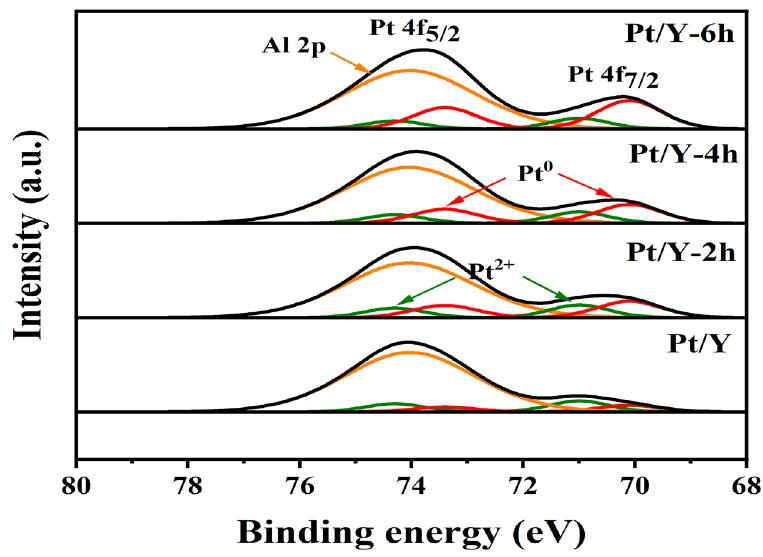
Figure 4. Deconvoluted Pt 4 f X-ray photoelectron spectra of the Pt/Y zeolites.